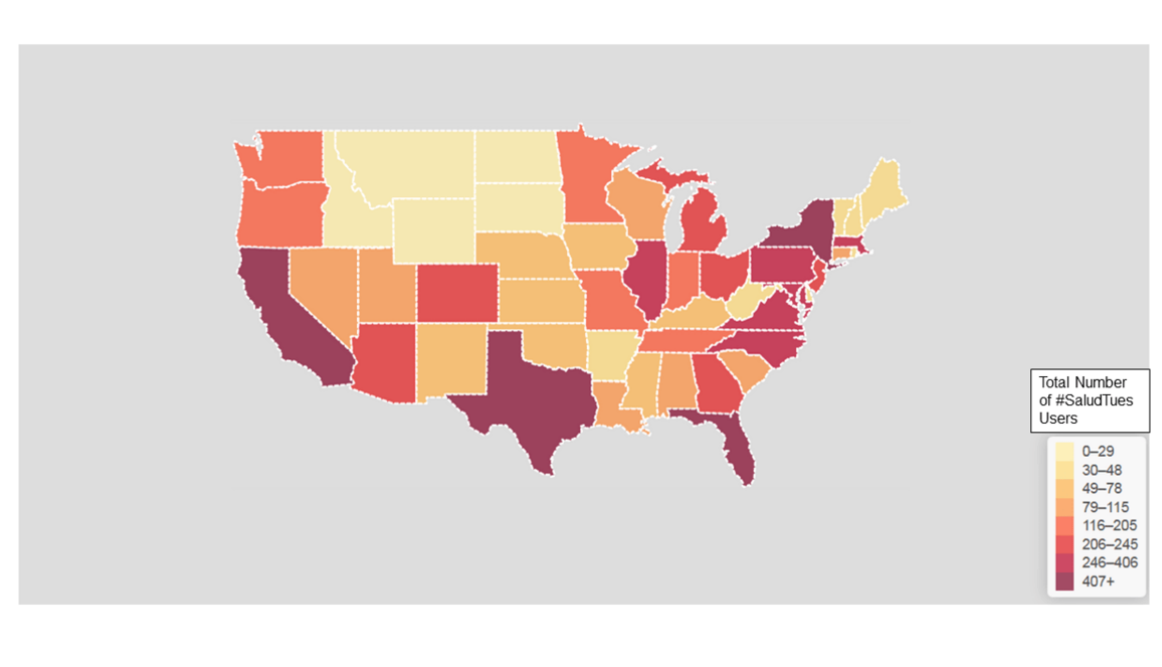
To illustrate the variety of #SaludTues trending terms, Salud America! used Symplur to create 2 bubble chart visualizations